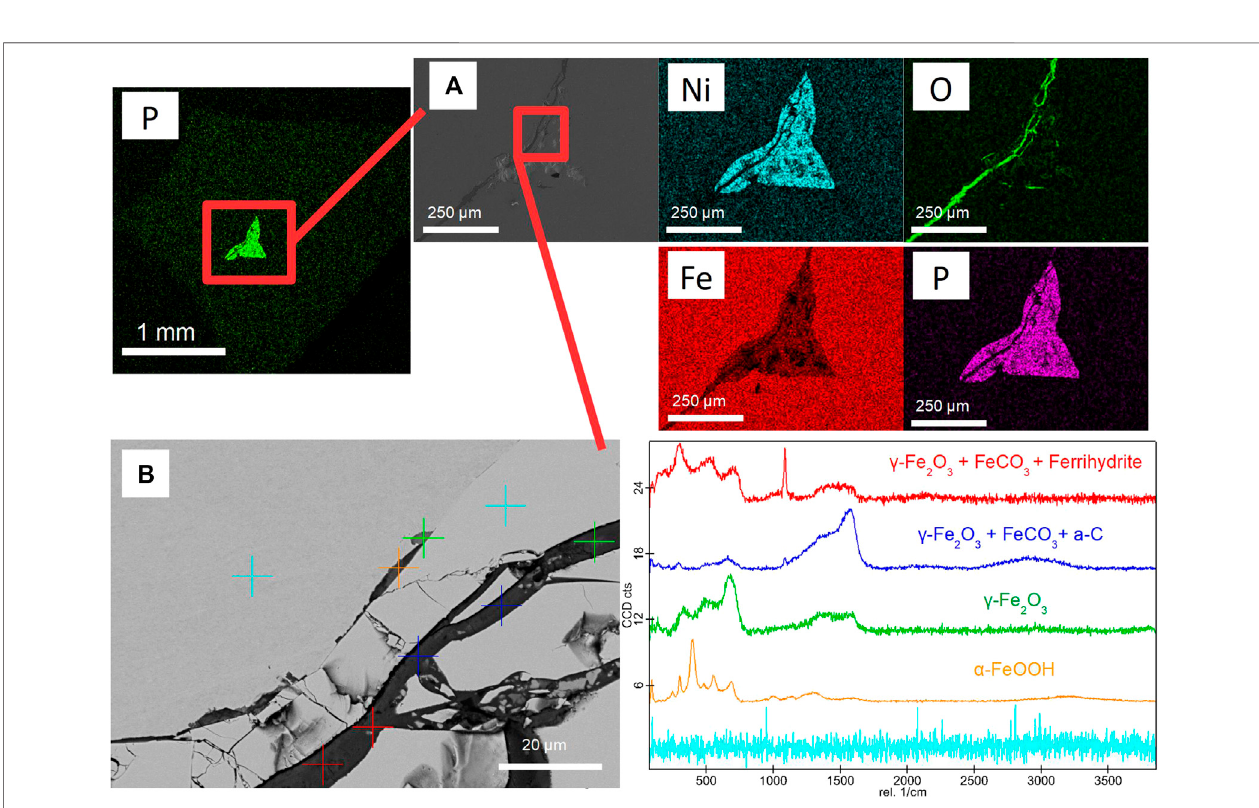
indicator on the left, both the Fe- and Fe – Ni – P phase show no Raman signal indicating predominantly metallic phases. In the oxide-phase on the other hand a complex composition of multiple different materials is revealed by Raman. The phase